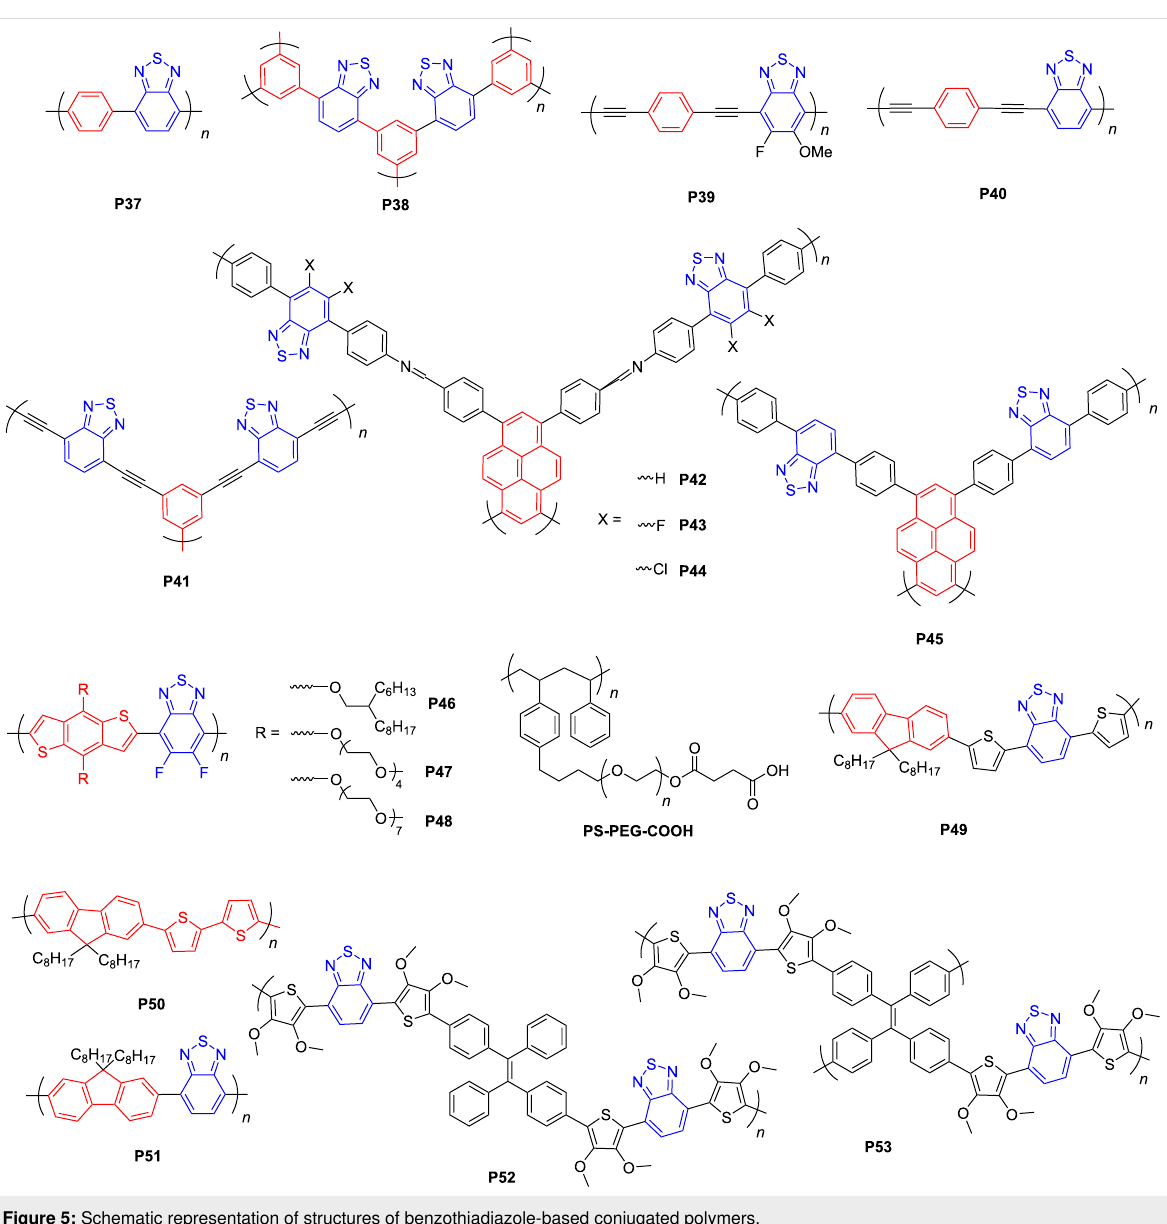
Figure 5: Schematic representation of structures of benzothiadiazole-based conjugated polymers.